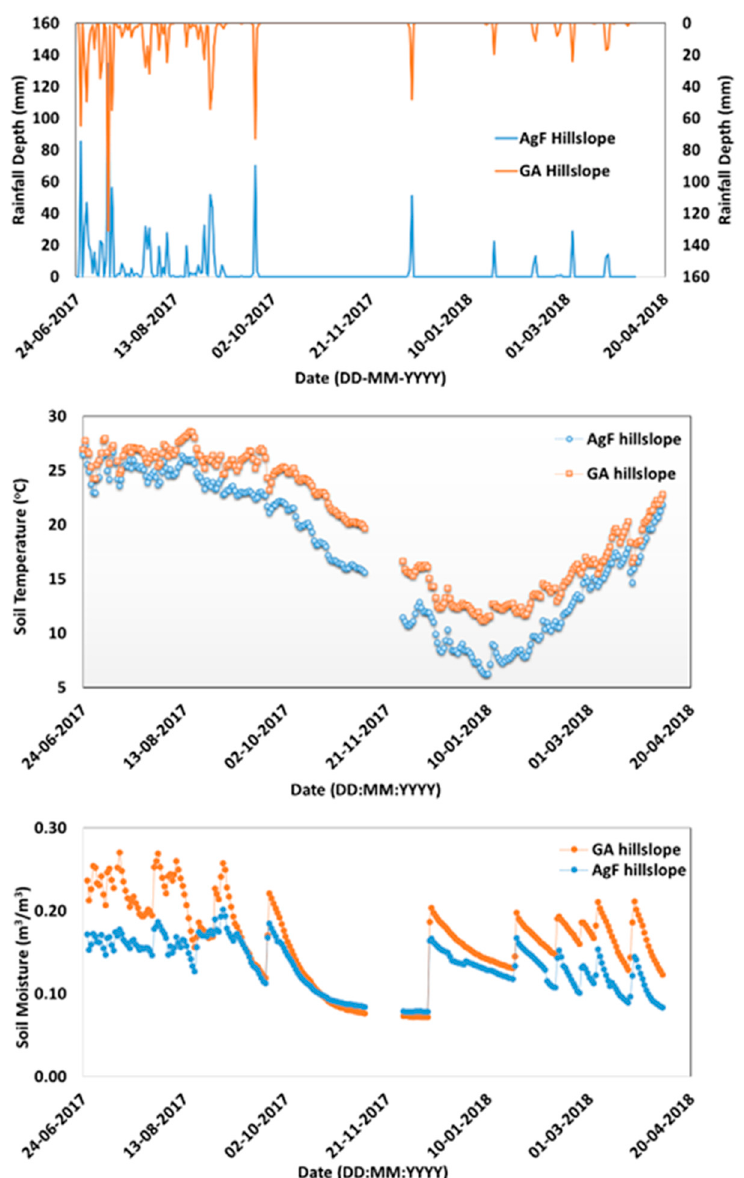
Figure 3. Time series of rainfall, soil moisture, and soil temperature for AgF and GA hillslopes.